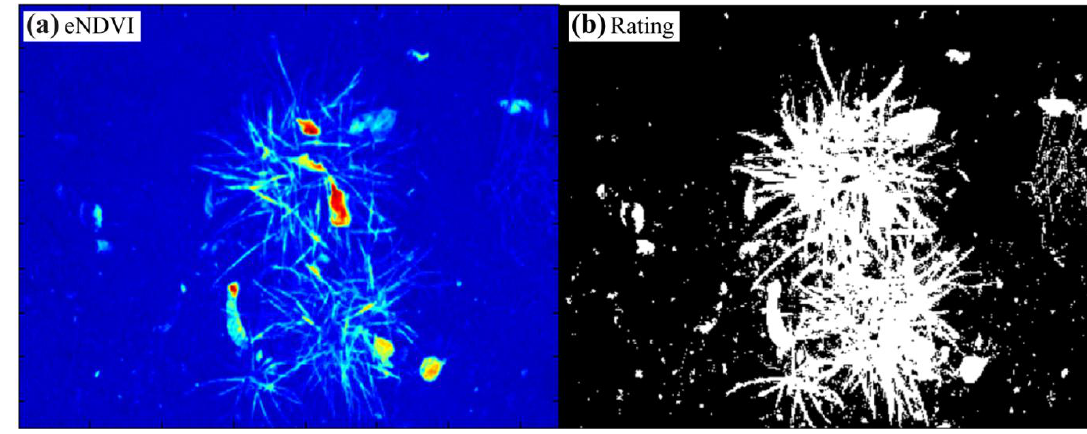
Figure 11. ( a ) Image of the eNDVI with the raw data from Figure 9 in rainbow colors CMOS from blue (zero) to red (256) and ( b ) the resulting binary image.